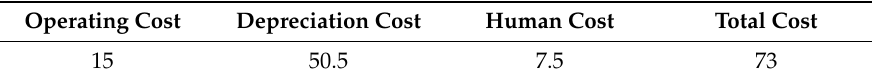
Table 9. Time cost for a single charging station (in RMB/h).